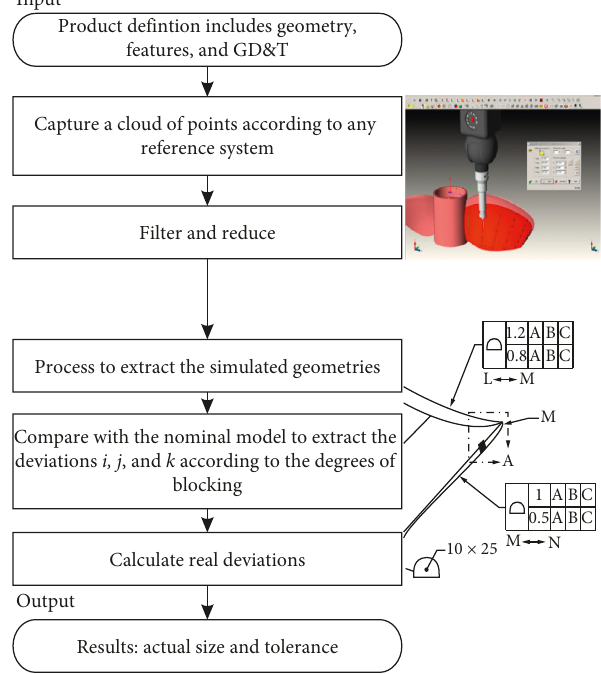
Figure 1: Inspection represents the radius. The Delaunay triangulation is used to calculate the convex and Voronoi diagram. In [9], the roundness error from the input 3D points is evaluated using four methods: minimum zone circle (MZC), least squares circle (LSC), MCC, and MIC. For the MZC method, the roundness error is measured using two con- centric circles. For the LSC method, it is estimated inside the profile by minimizing the sum of radial squares between the circle and the profile. Using the center of the LSC, a circumscribed circle and an inscribed circle are obtained. The circularity error (out of roundness) value is the radial separation. The MIC method is used to fit the largest circle inside the profile. In the case of a MCC, a center is cal- culated by finding the circle that has the smallest radius containing the points of the circle. The circularity error is the difference between the radiuses of the inscribed circle drawn using the found center and the circumscribed circle.